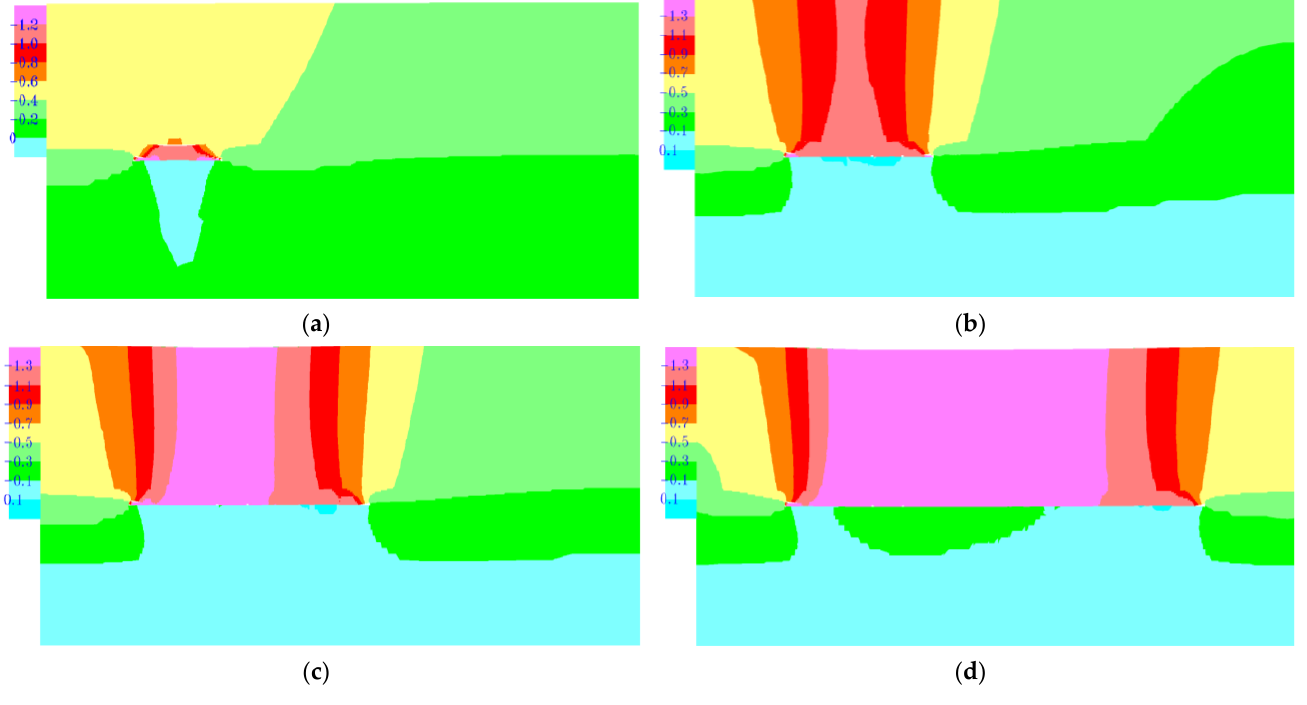
Figure 6. Coal and rock displacements when the working face is advanced at different distances: ( a ) coal and rock displacements when the working face is advanced at 30 m; ( b ) coal and rock displacements when the working face is advanced at 50 m; ( c ) coal and rock displacements when the working face is advanced at 80 m; and ( d ) coal and rock displacements when the working face is advanced at 140 m.